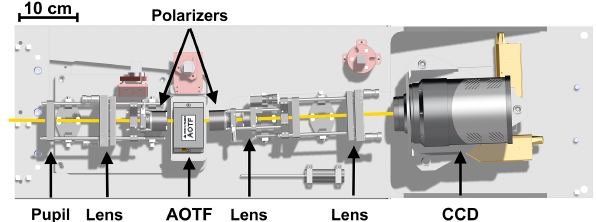
Figure 1. Optical layout of the NO 2 camera seen from top. Light propagates from left to right through a pupil and a lens doublet, a polarizer selecting vertically polarized light, the AOTF, a second cross-oriented polarizer, two lens doublets and the